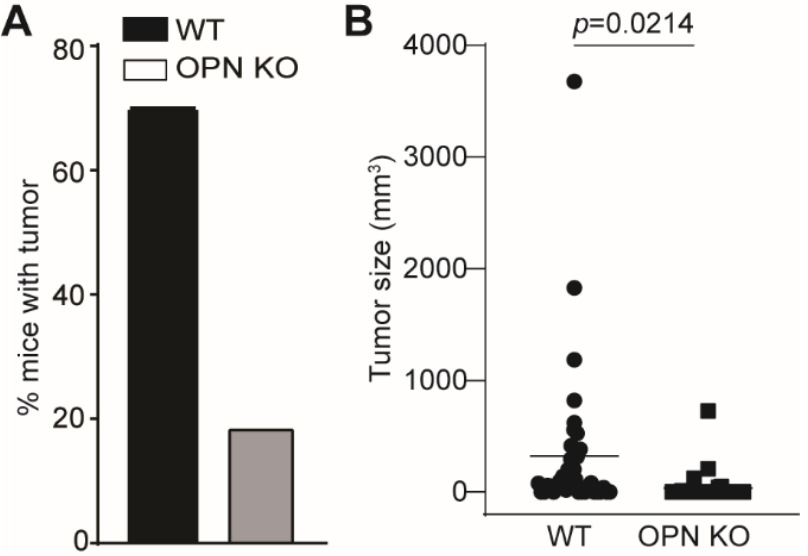
Figure 4. OPN promotes tumor development. ( A ) WT ( n = 37) and Spp1 KO ( n = 32) mice were injected with MCA and monitored for tumor development. Shown are percentages of WT and OPN KO mice with tumor 102 days after MCA injection. ( B ) The tumor sizes were measured in WT and OPN KO mice and plotted.